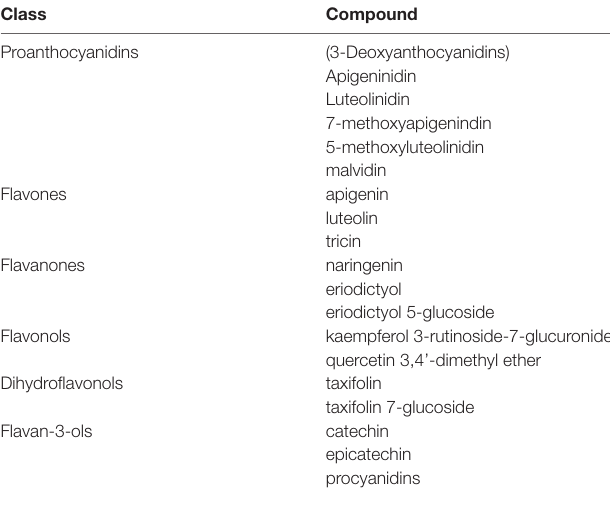
TABLE 1 | Reported flavonoids in sorghum (Vanamala et al., 2017).